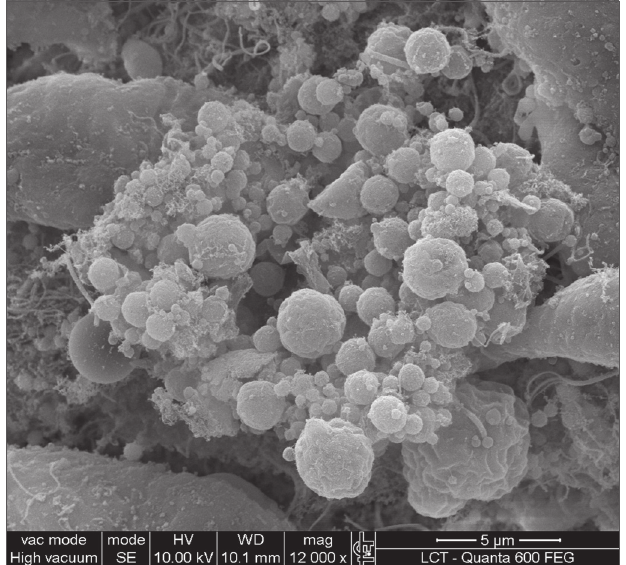
Figura 5. Biofilme bacteriano